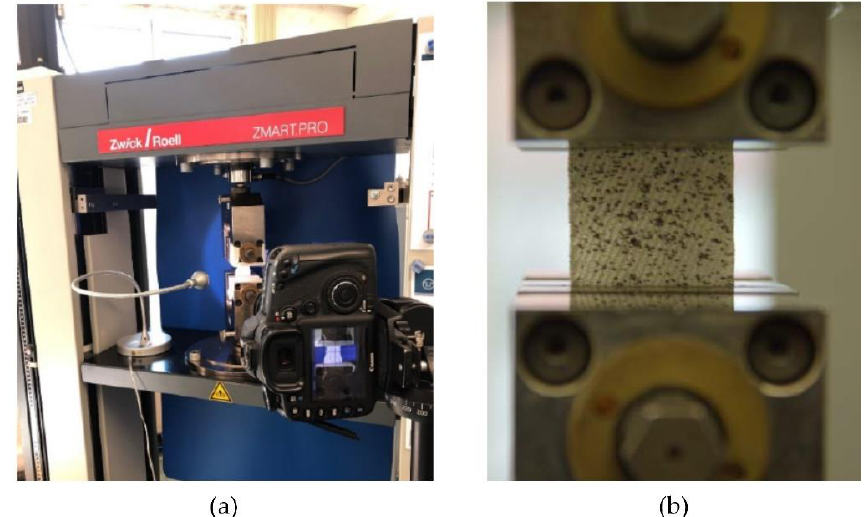
Figure 3. ( a ) Measuring setup for determining stress-strain behavior of fabrics and ( b ) clamped test specimen with speckle pattern.